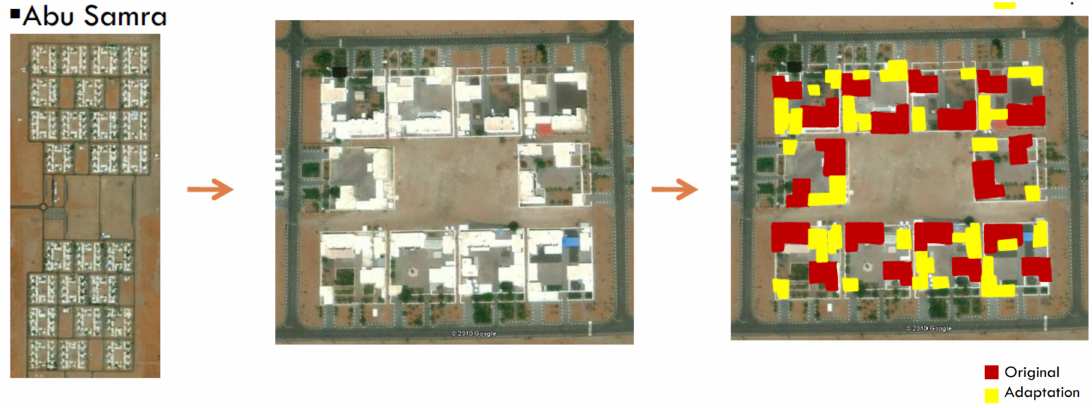
Figure 1. Residents’ adaptations of their houses, Abu Samra social housing development in Al Ain